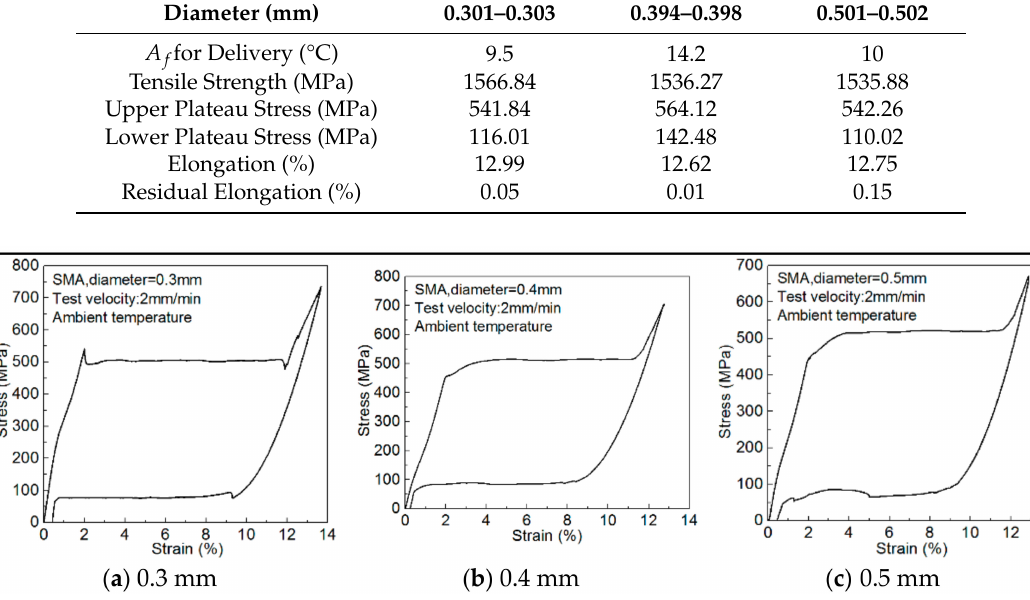
Figure 1. The stress–strain diagram of Ni-Ti shape memory alloy